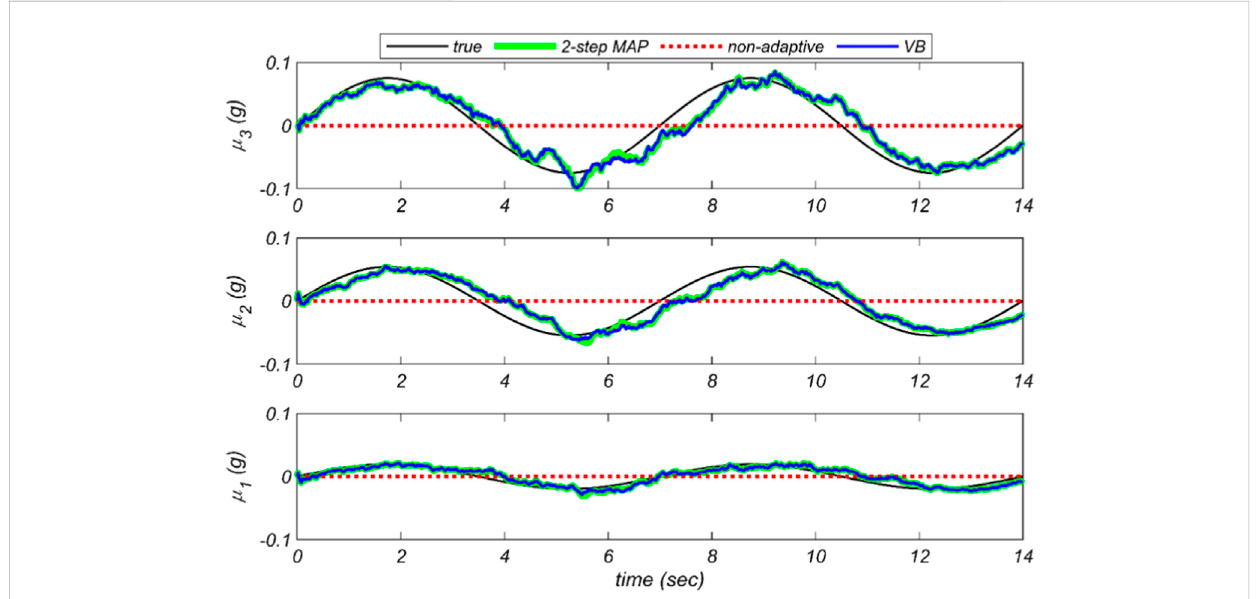
FIGURE 3 Comparison of the estimated components of the mean vector of measurement noise by the three methods (VB, two-step marginal MAP, and the non-adaptive) with the true ones. It should be noted that μ (cid:2) [ μ 1 μ 2 μ 3 ] T .